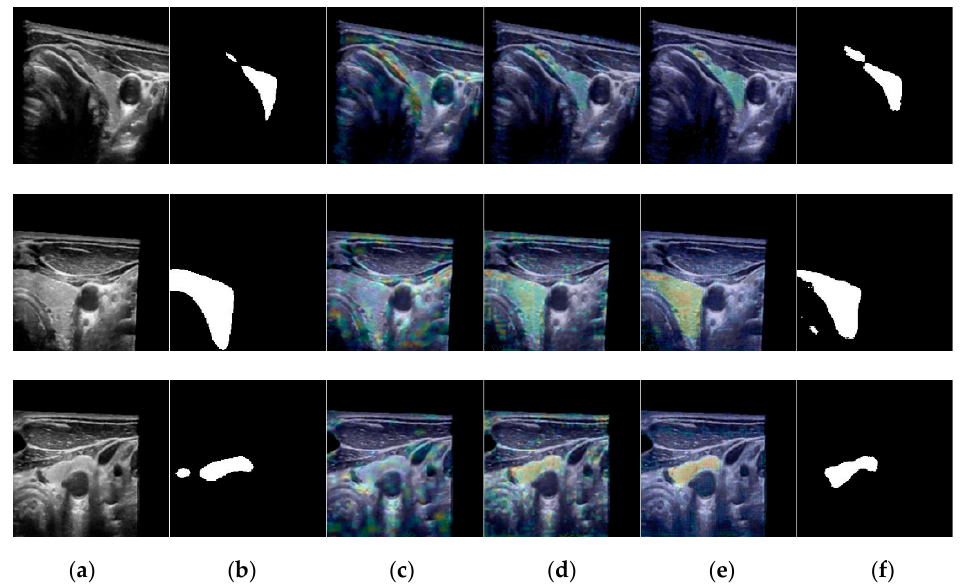
Figure 13. Examples of CAM images using our proposed network: ( a ) input image; ( b ) label images;